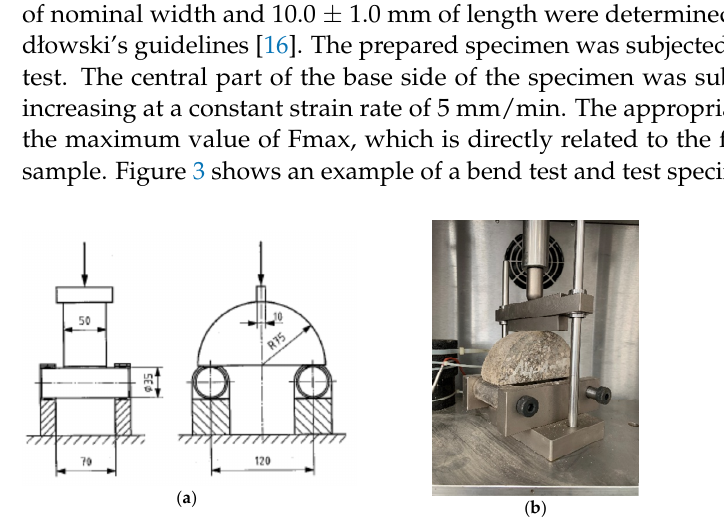
Figure 3. Semi-circular bending test set-up and specimen: ( a ) standard scheme (source: PN-EN 12697-44 [42]); and ( b ) fracture toughness test set-up (laboratory at Faculty of Civil Engineering and Architecture, Kielce University of Tecnology, Kielce, Poland) [49].